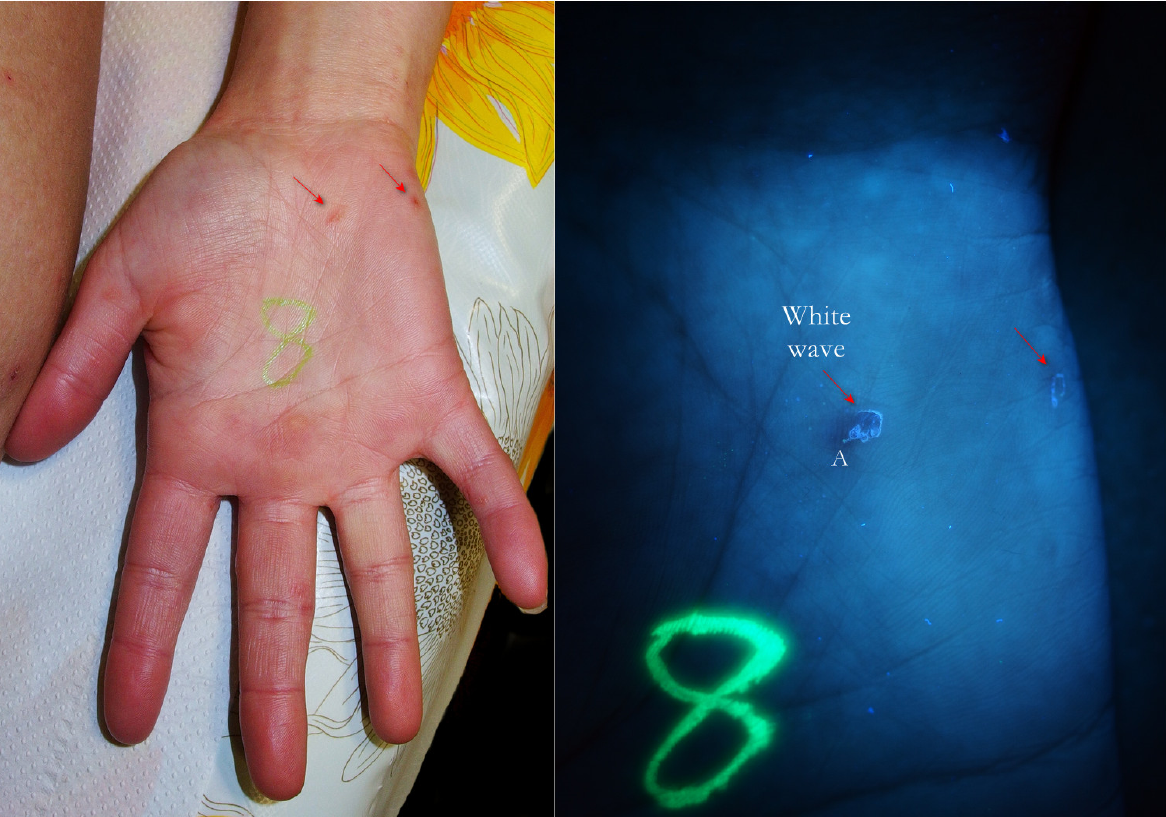
Figure 5. Flash light vs. UVA. Two MGUs appeared as pink fuzzy streaks ( left , red arrows). Under UVA they became clear linear structures (white waves), as in the pathognomonic sign of scabies. At one extremity, a little white dot was recognizable (A). A yellow highlighter was used.